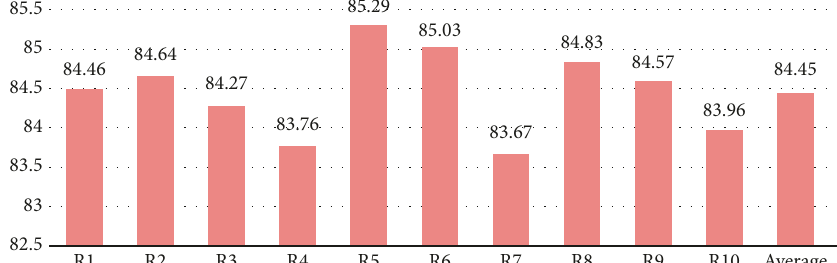
Figure 6: Results of 10 runs of the proposed method in the classification precision criterion with an average of 10 runs.